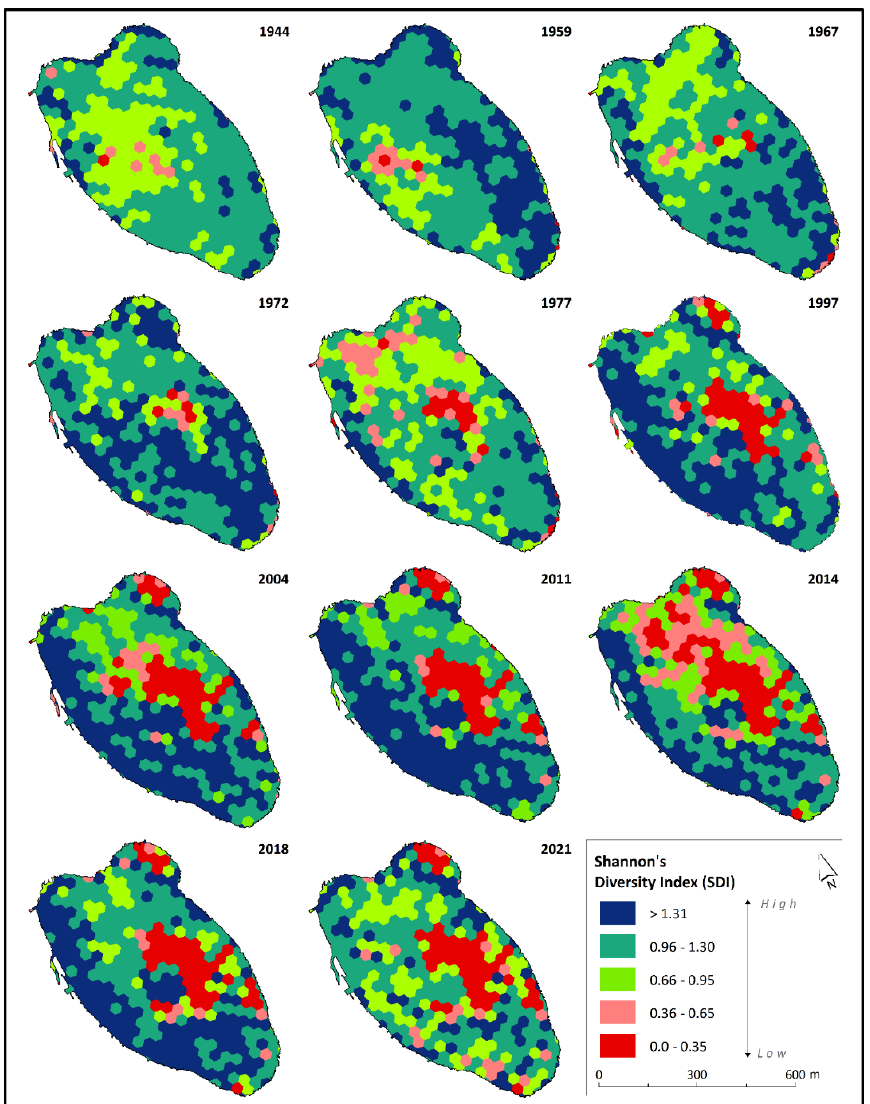
Figure 16. SHDI per zones for Ošljak (1944—2021). The dominance of Aleppo pine within the defined statistical zones of the Ošljak